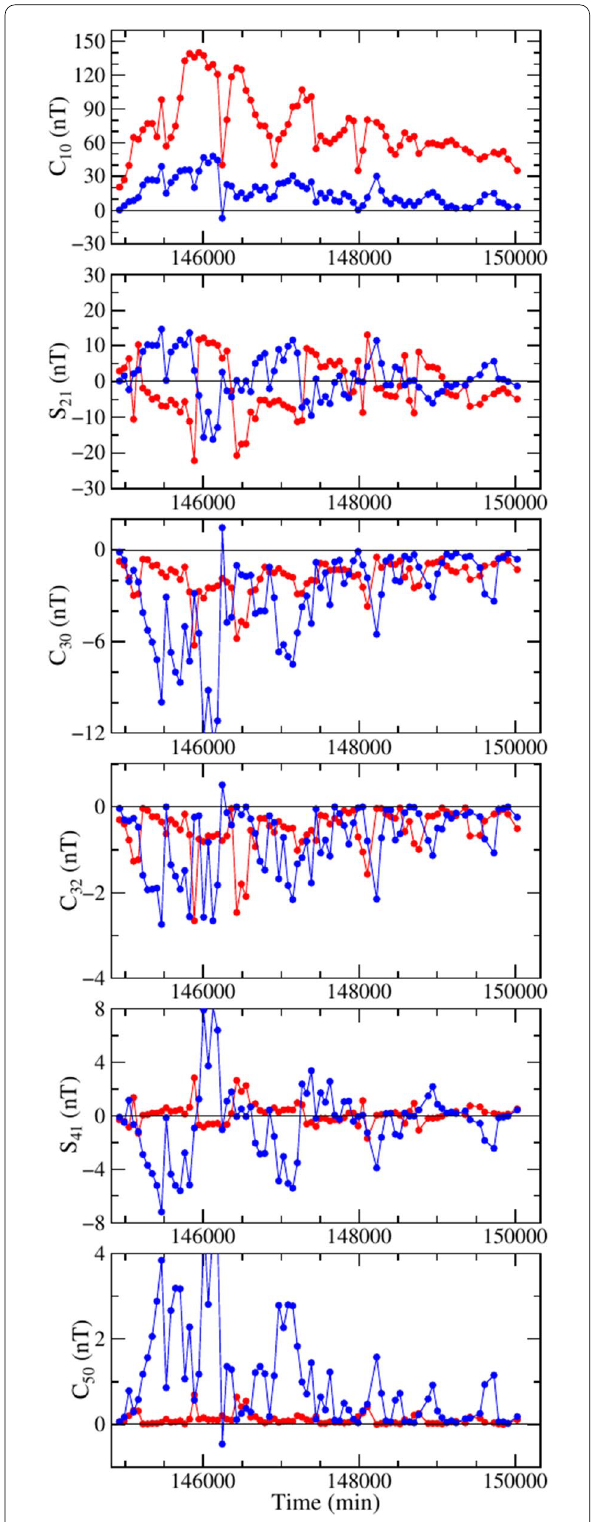
Fig. 16 The time evolution of external coefficients C ( e ) jm and S ( e ) jm (red), and internal coefficients C ( i ) jm and S ( i ) jm (blue) up to degree j = 5 whose magnitudes are larger than 1 nT. Time span covers the magnetic storm analysed in Fig. 1